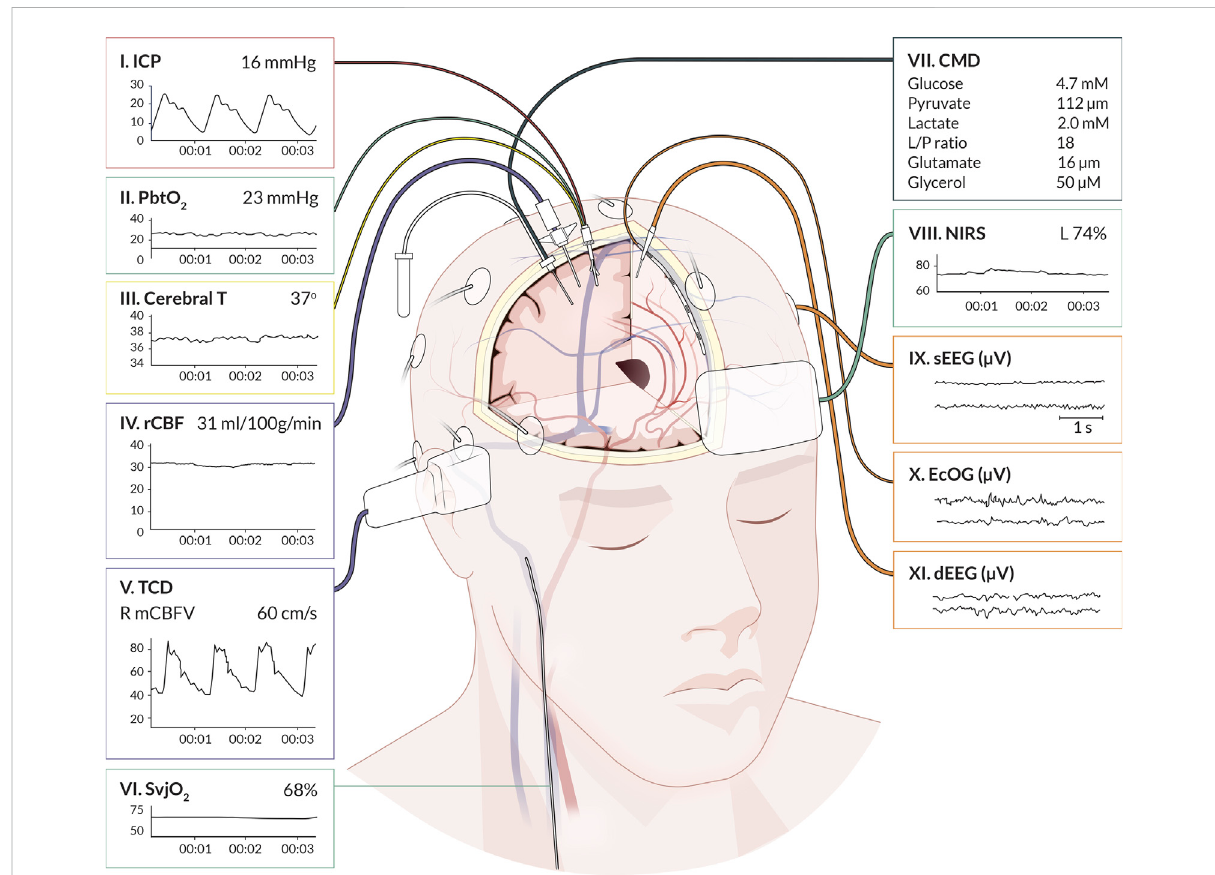
FIGURE 1 Graphical representation of cerebral multimodality monitoring modalities. The eleven applied monitoring modalities with numbers and (raw) signals. Each modality presents the standard visualization on the bedside monitoring screen. For the readability of the fi gure, only two neuronal activity monitoring electrodes are displayed. In common practice, the numbers for sEEG are application of 21 electrodes, for ECoG and dEEG 4- 8 electrodes. Cerebral T, cerebral temperature; CMD, cerebral microdialysis; dEEG, depth electroencephalography; ECoG, electrocorticography; ICP, intracranial pressure; NIRS, near-infrared spectroscopy; PbtO 2 , partial pressure of brain tissue oxygenation; rCBF, regional cerebral blood fl ow; sEEG, surface electroencephalography; SvjO 2 , jugular bulb venous oximetry; TCD, transcranial Doppler. Professional illustration by Anna Sieben (Sieben Medical